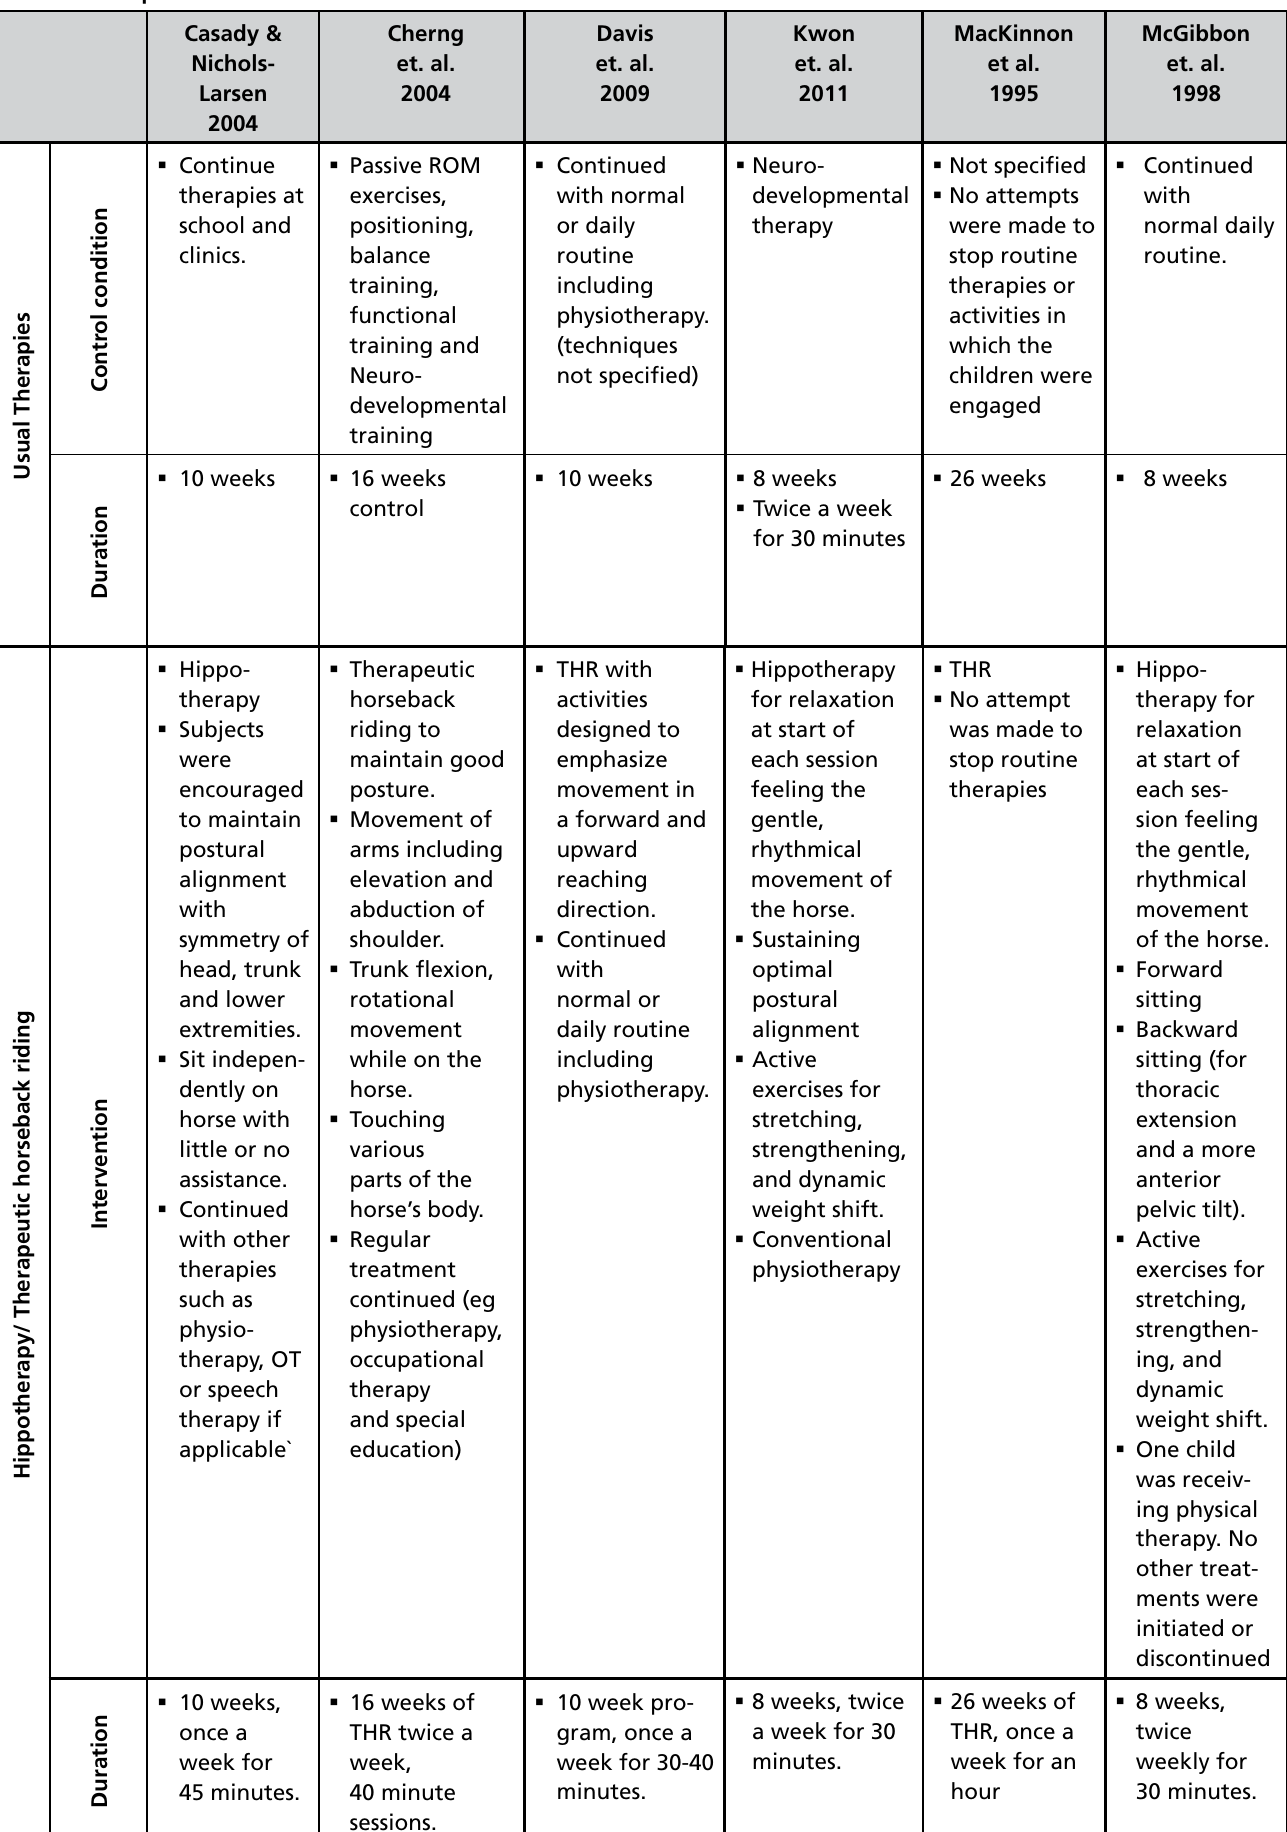
table 3: Description of